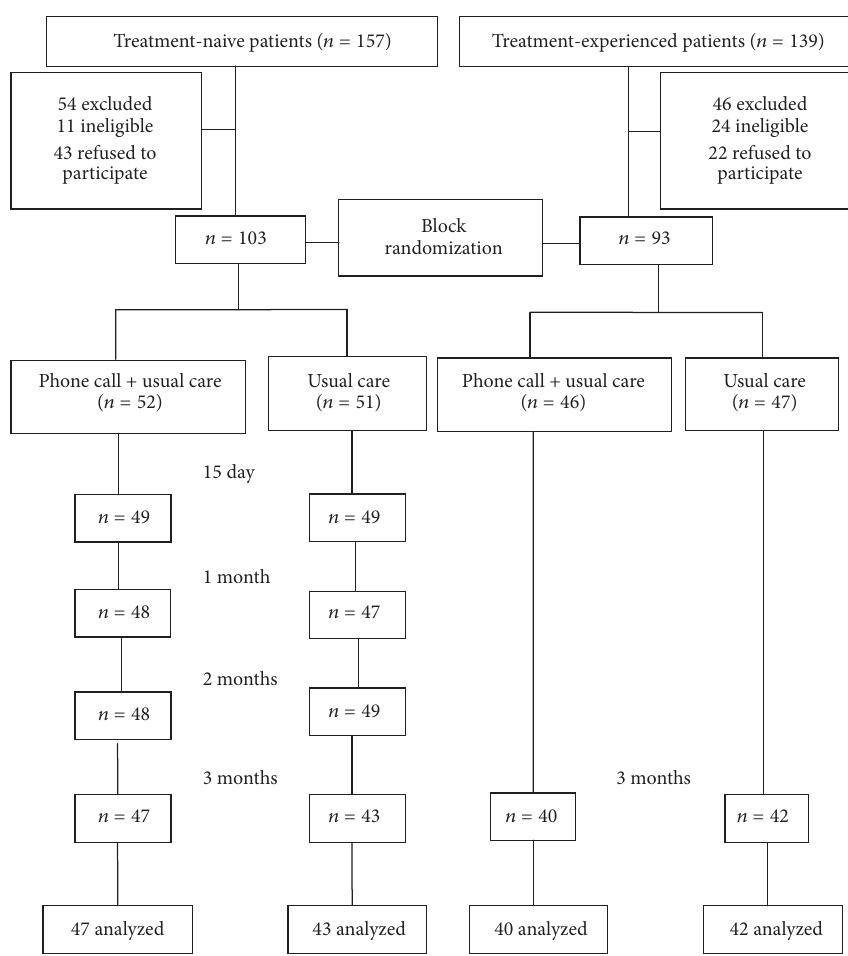
F 1: Flow chart of study